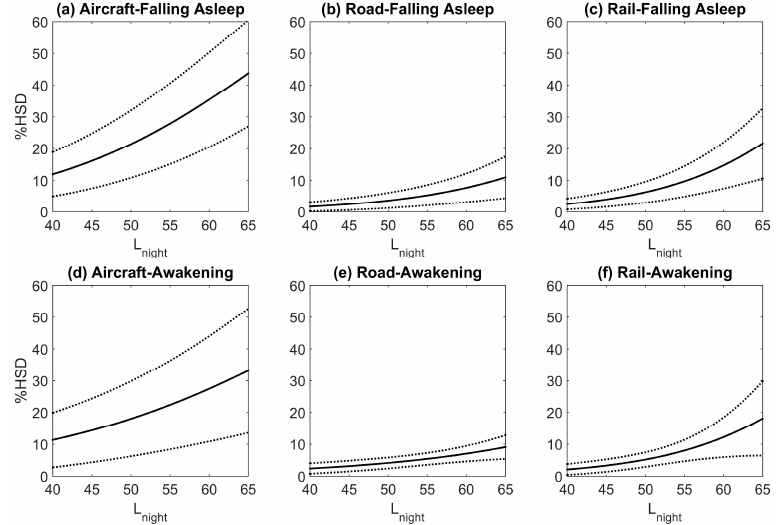
Figure 7. The percent highly sleep disturbed (HSD) based on responses to questions on awakenings or difficulty falling asleep for road, rail, and aircraft noise and for studies that asked about how noise affects sleep (black dashed lines: 95% confidence intervals). The number of studies and subjects contributing to the analyses can be found in Tables 2–4.